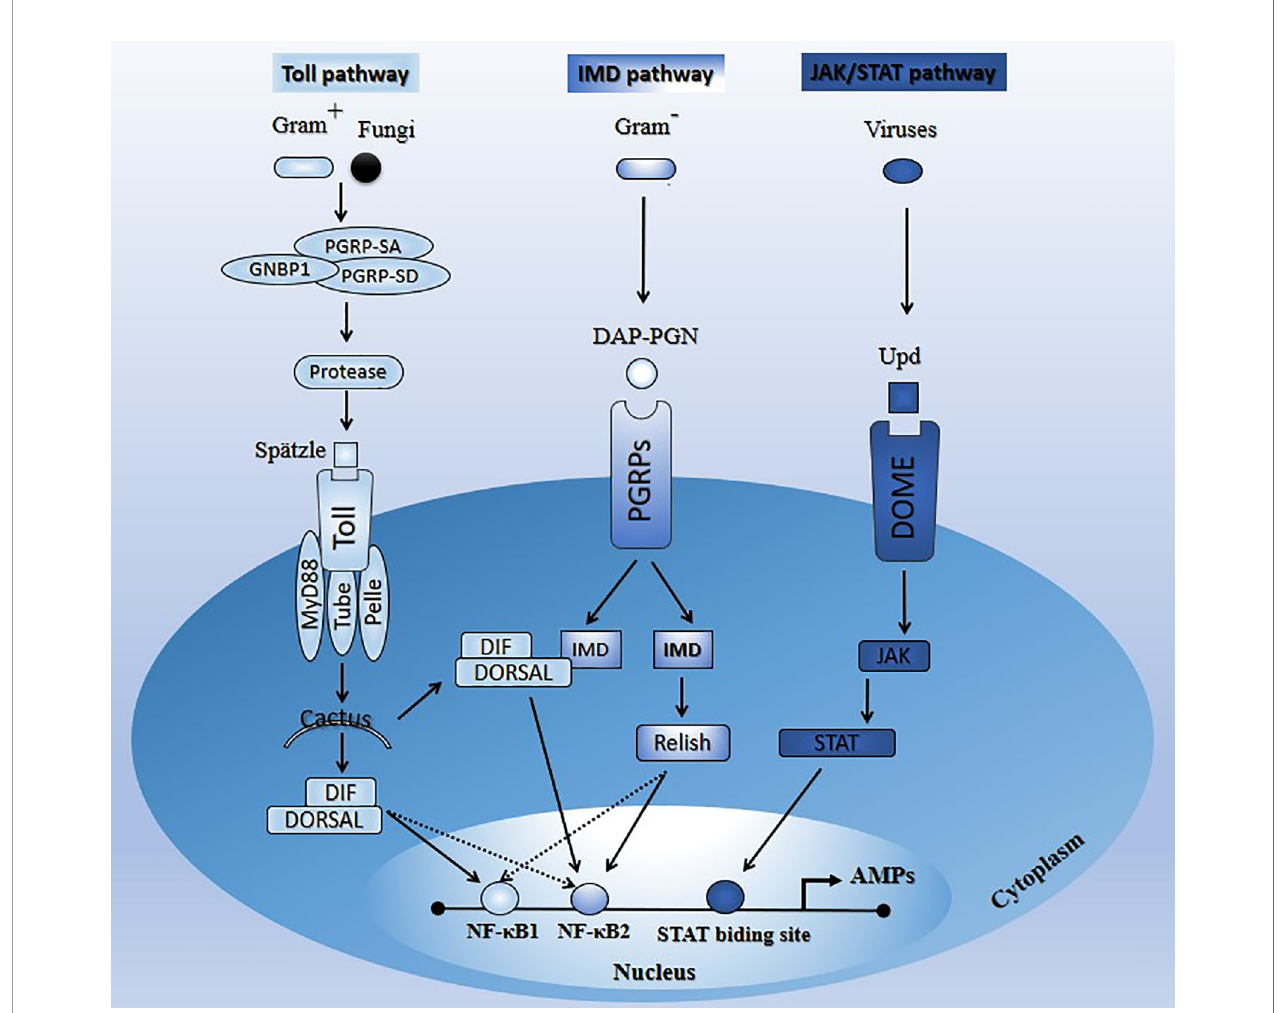
FIGURE 1 | Schematic illustration of the main signaling pathways (Toll, Imd, and JAK/STAT) in insects upon microbial attacks. See Section 2 for the description of the